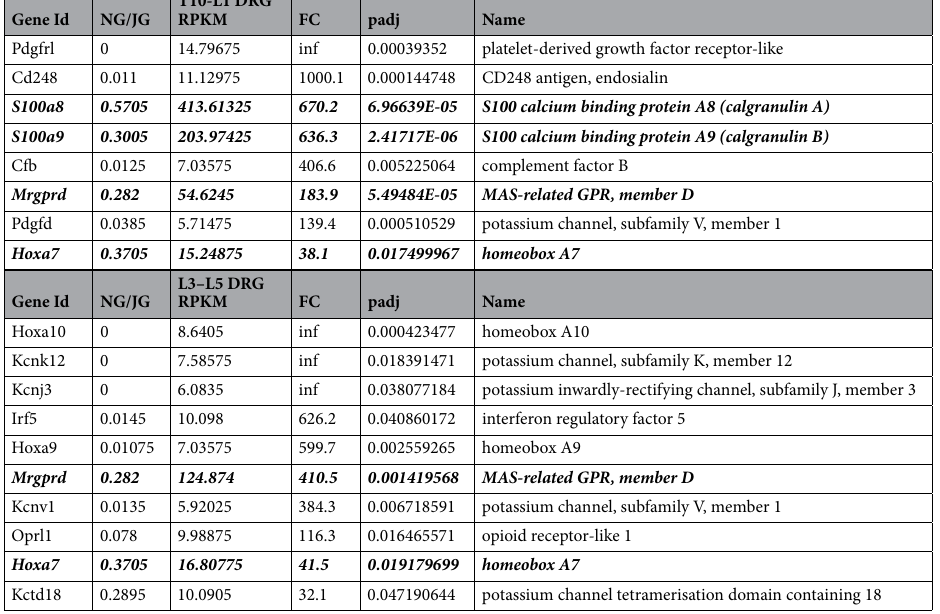
Table 3. A partial list of DEGs predominantly presented in L3–L5 and T10-L1 DRG compare to NG/JG sensory neurons. DEGs common for T10-L1 DRG > NG/JG and L3–L5 DRG > NG/JG are presented in bold